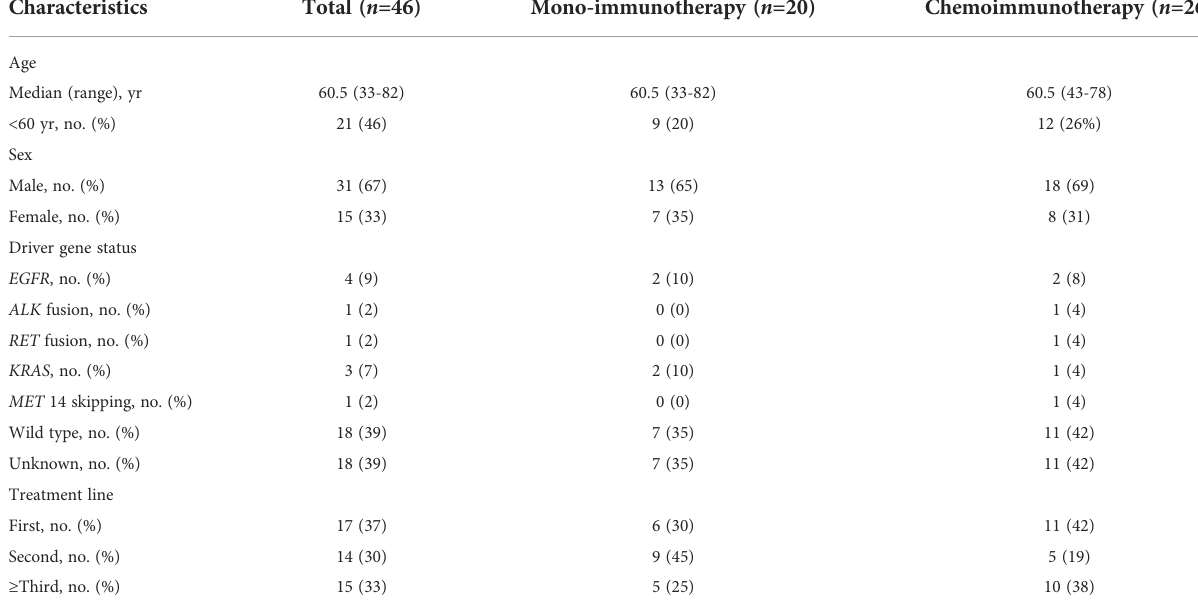
TABLE 1 Demographic and disease characteristics of real-world lung ASC patients.